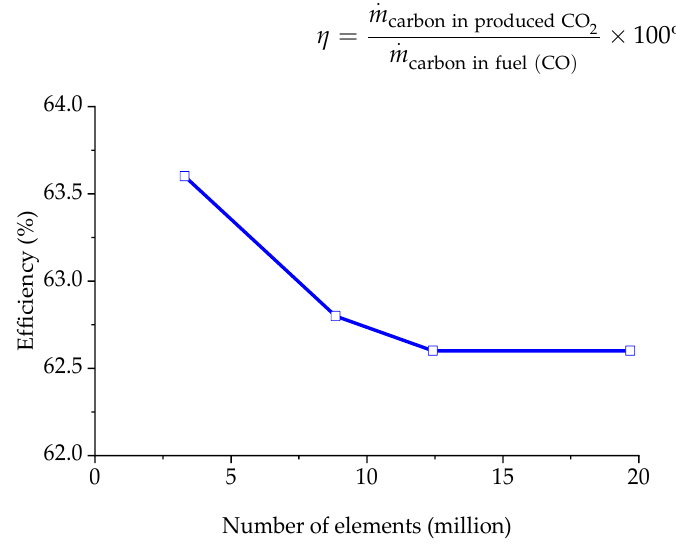
Figure 6. Grid independence test with different numbers of elements. There was a minor difference when the number of elements was higher than 8 million.